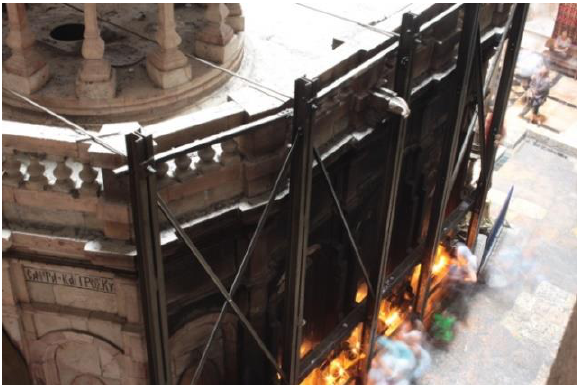
Figure 1: The Church of the Holy Sepulchre Today the Church complex is a living monument and it is visited every year by thousands of pilgrims. All different Christian Communities are represented and active within its walls. Greek Orthodox, Roman Catholic Franciscan, Armenian and Coptic priests and monks and others are coexisting in harmony worshipping the same God. The monument is divided into sections each one “belonging” to a Community. There are, of course, sections of it common to everybody. All Christian Communities respect this unique state of ownerships while it is hardly sensed by the visitors. It constitutes the Status Quo of the Church of the Holy Sepulchre, which has its origins in historical tradition.